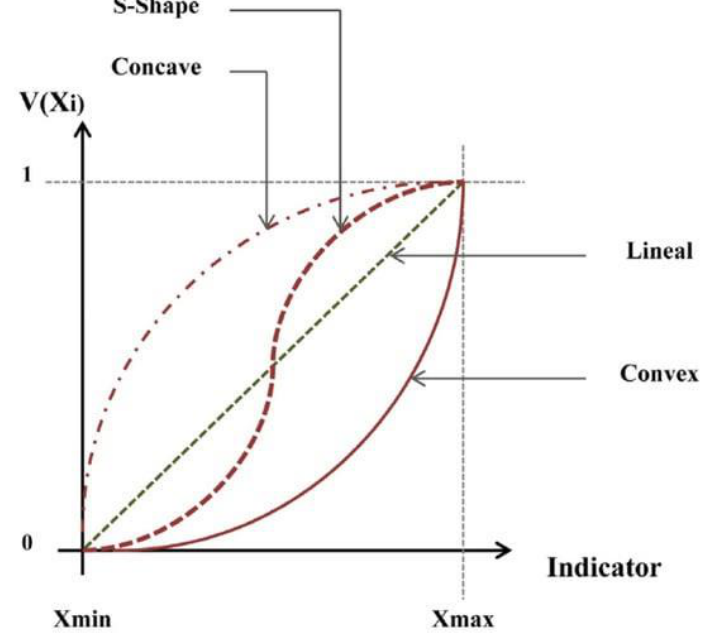
Figure 3 . Forms of the value function